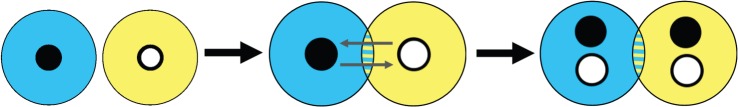
Schematic representation of a mating between two monokaryons. In a mating between two monokaryons, both nuclei (one white, one black) migrate to fertilize their respective partner mycelium. The cytoplasms, and thus the mitochondria (blue and yellow), are not exchanged, except for in the narrow interaction zone in which the hyphal tips fuse (blue and yellow stripes). Consequently, a single dikaryon is formed in which all cells have the same nuclear genotype, but may have different mitochondrial genotypes.